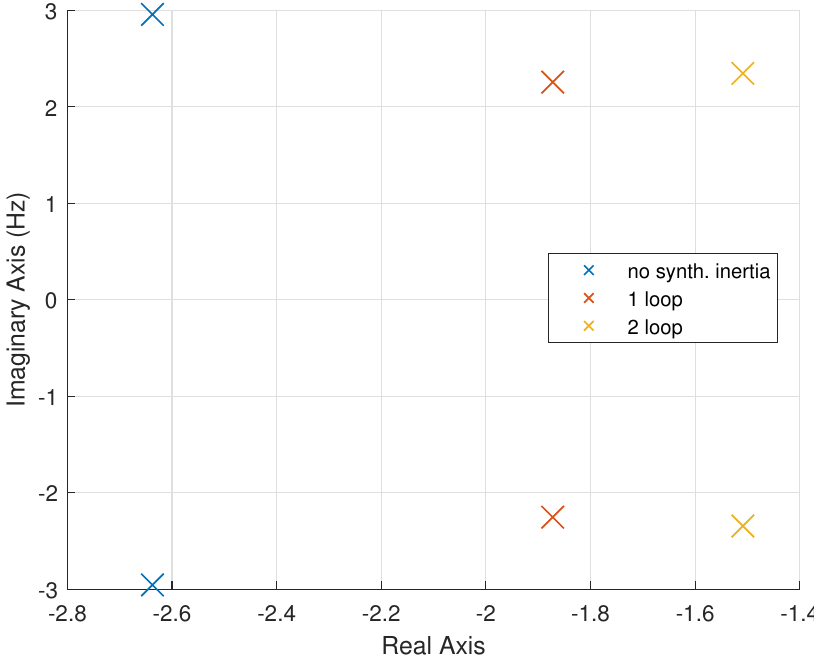
Figure 7. Pole-plot of dominant eigenvalues for ∆ ω modes—scenario